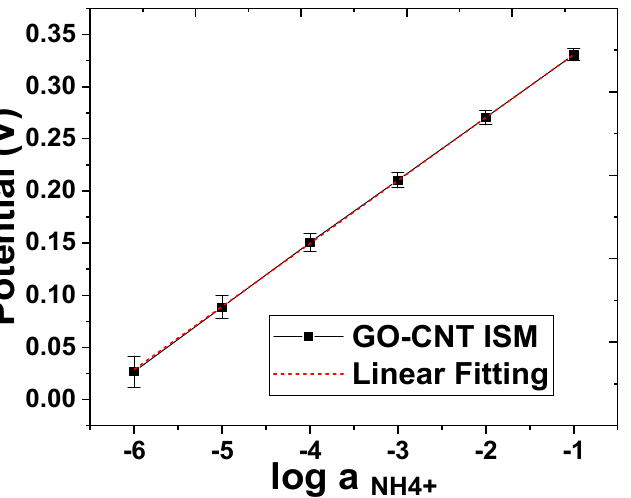
Figure 6. The potentiometric response to a series of testing solutions with NH 4+ concentrations from 10 − 6 M to 10 − 1 M using a sensor with working electrodes modified by Graphene–CNT with an NH 4+ ISM coating.